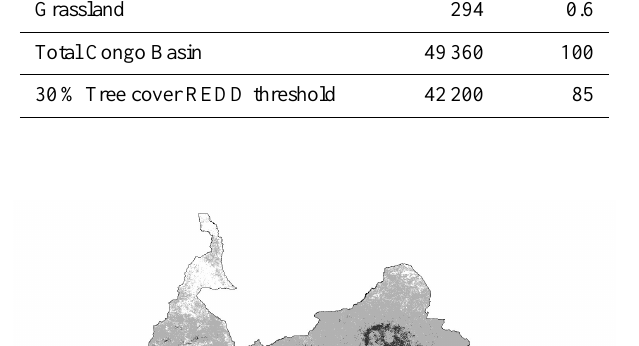
Fig. 14. Spatial representation of the carbon stock in tha − 1 by veg- etation types; the region is stratified with the Congo basin vegeta- tion types map and the C stocks values are coming from Nasi et al.